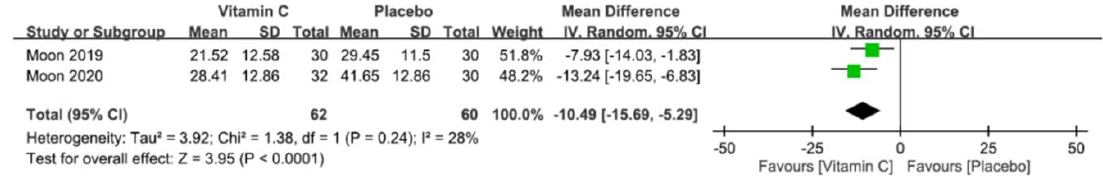
Figure 10. Forest plot for comparing opioid consumption (mg) within 48 h after surgery between vitamin and placebo groups. CI, confidence interval; IV, inverse variance.